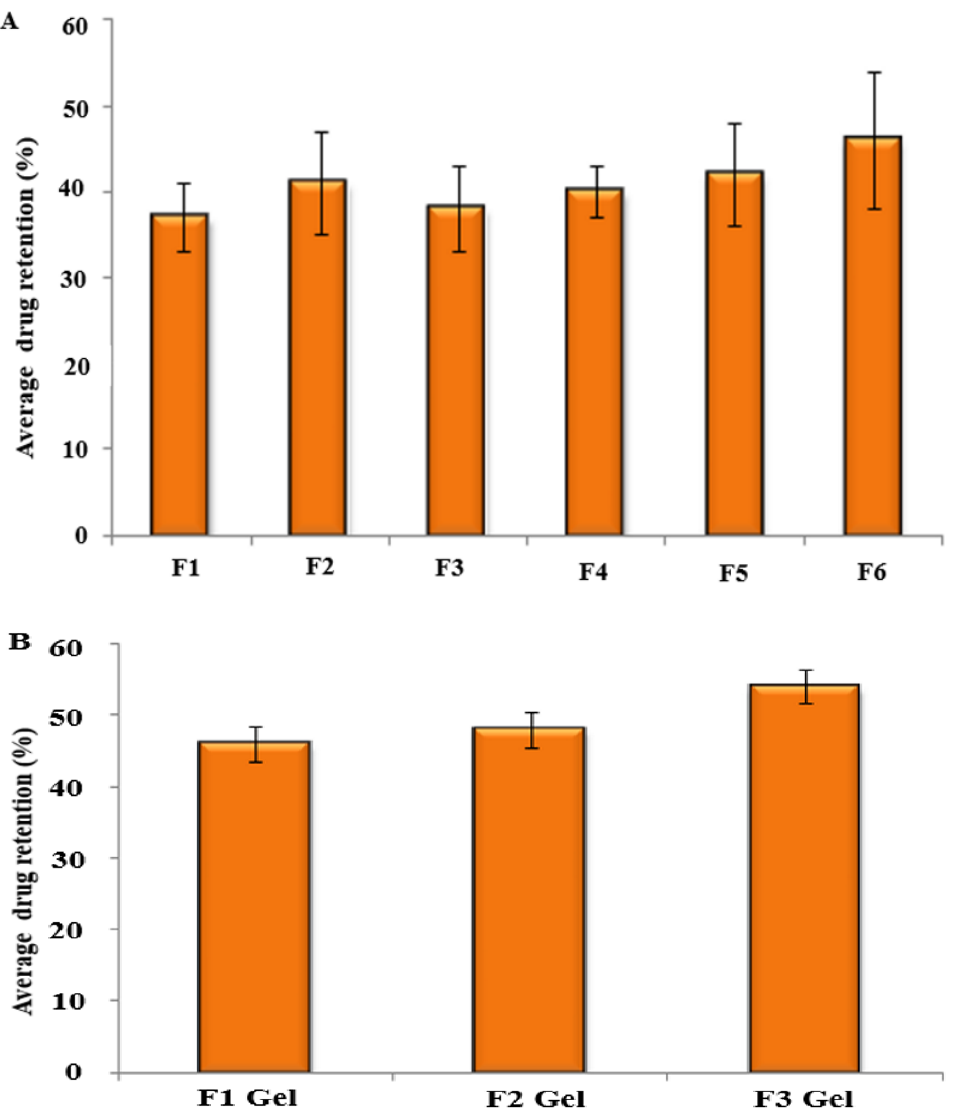
Figure 5. Drug retention profile in the skin from ( A ) SLN formulations and ( B ) SLN-loaded gel.